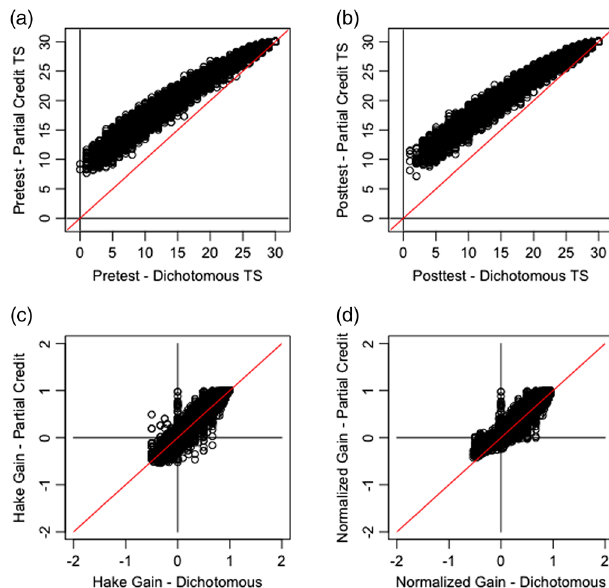
FIG. 6. Plots comparing the results for the FCI using dichoto- mous scoring and the proposed partial credit scoring. (a),(b) Partial credit total scores vs the dichotomous total scores for students on the FCI pretest and post-test, respectively. (c),(d) Partial credit ’ s vs the dichotomous Hake gain and normalized gains, respectively. The red lines in all of the plots are a slope equals 1 line to be used for